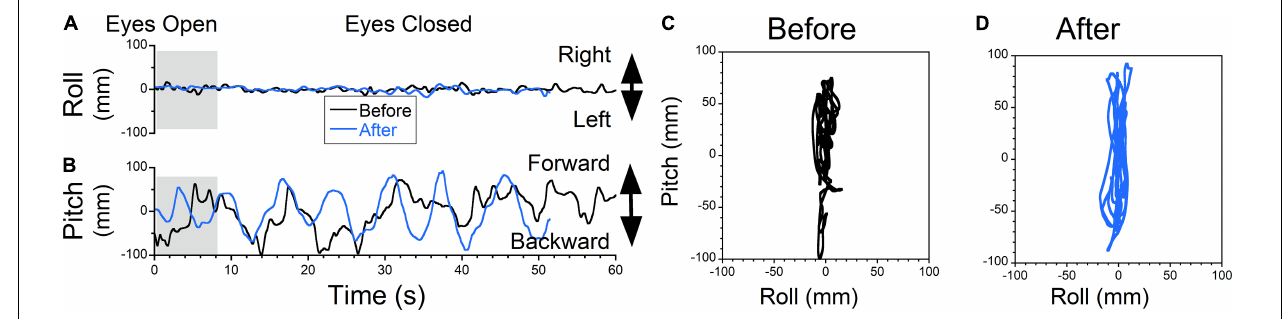
FIGURE 9 | Static posturography of a 52-year-old female with MdDS of unknown origin (possibly swimming). Details of individual plots are described in Figure 6 . The patient did not experience any swaying ( A , black trace) but reported a sensation of rocking and backwards gravitational pulling ( B , black trace). Forward-back motion was irregular but deviations forward and back were of similar amplitude. Thus, static posturography did not have a typical pattern of rocking or gravitational pull sensation forward or backward. After exposure to OKS to the right at 5 ◦ /s while rolling the head at 0.1 Hz for 3 min (treatment for rocking), swaying remained minimal ( A , blue trace) but rocking became stronger and regular at 0.15 Hz ( D , blue traces). The patient reported worsening of her symptoms. At the same time fore-aft oscillations became regular (C,D) . The appropriate treatment should have been upward OKS for the pulling back sensation. This shows that inappropriate treatment, based on some “intuitive” notion and not model-based could have deleterious